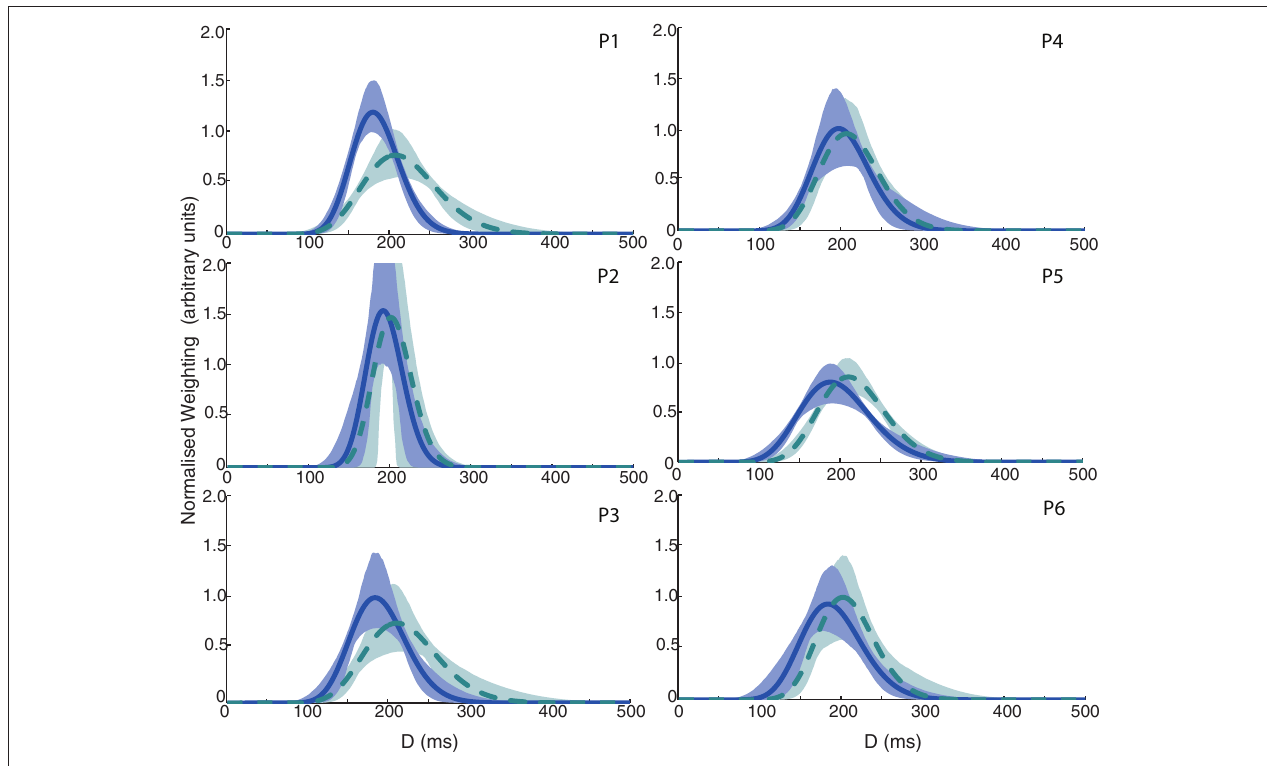
Figure 5 | Velocity integration filters for all six observers in experiment 1. Solid dark blue line denotes the plot based on the high contrast data; dashed light blue line denotes the plot for the low-contrast data. Shaded areas indicate 95% confidence limits based on 10,000 bootstrap replications (dark blue and light green for high and low-contrast